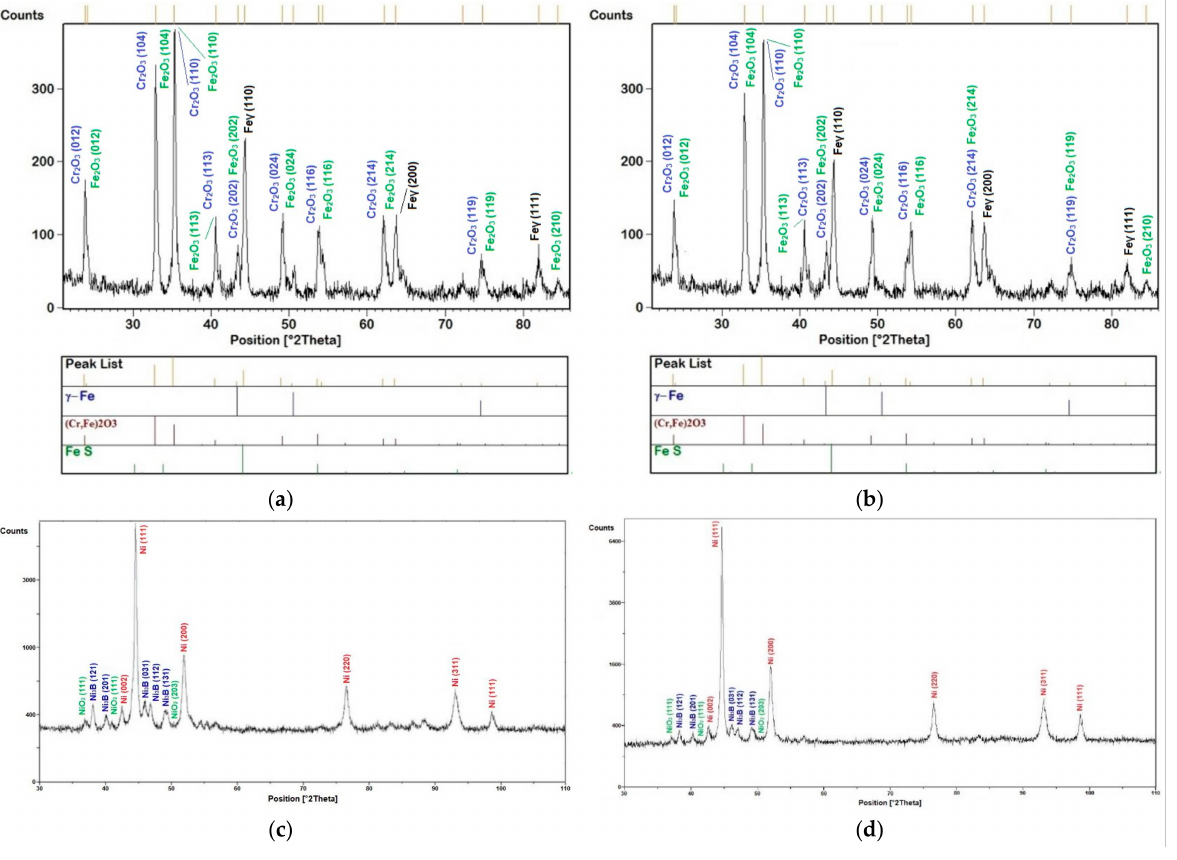
Figure 10. Results of analysis of the phase composition of corrosion products after high-temperature corrosion resistance tests at 800 ◦ C for 1000 h of flame-sprayed coatings: ( a ) Eutalloy ® RW